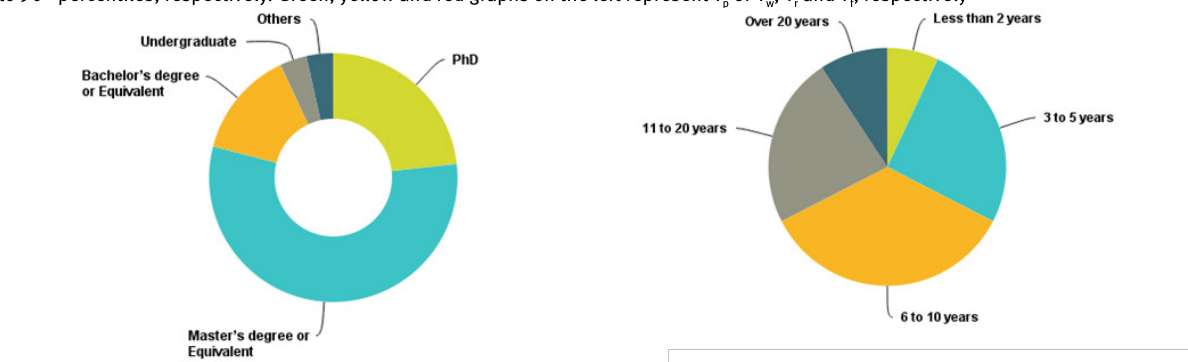
Figure 2: Levels of potato yields and yield gaps in selected sites of Sub-Saharan Africa: georeferenced graphs showing Y plots ( right ). The X-Axis presents the following yields: Y and Sussundenga); Y = maximum yield attained by researchers; Y r yield gap; Y = absolute yield gap. Lines within boxes show the medians (solid line) and the boxes and whiskers represent 25 th to 75 th and 10 th g to 90 th percentiles, respectively. Green, yellow and red graphs on the left represent Y